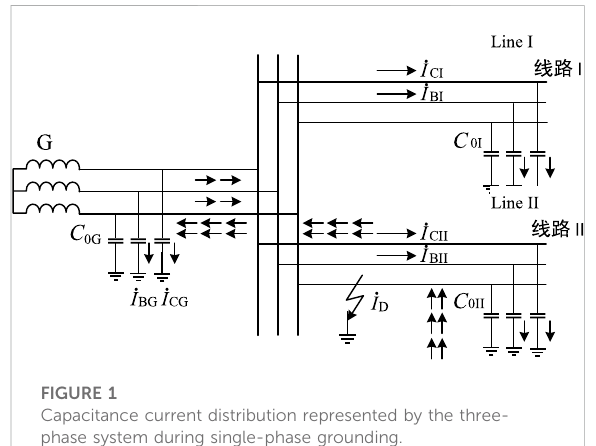
FIGURE 1 Capacitance current distribution represented by the three- phase system during single-phase